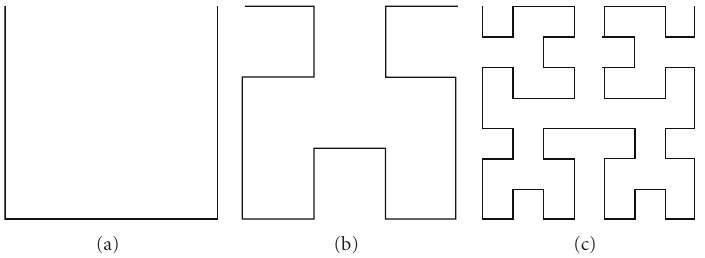
Figure 1: The Hilbert curves with increasing iteration order number n . (a) First order, (b) Second order, and (c) Third order.